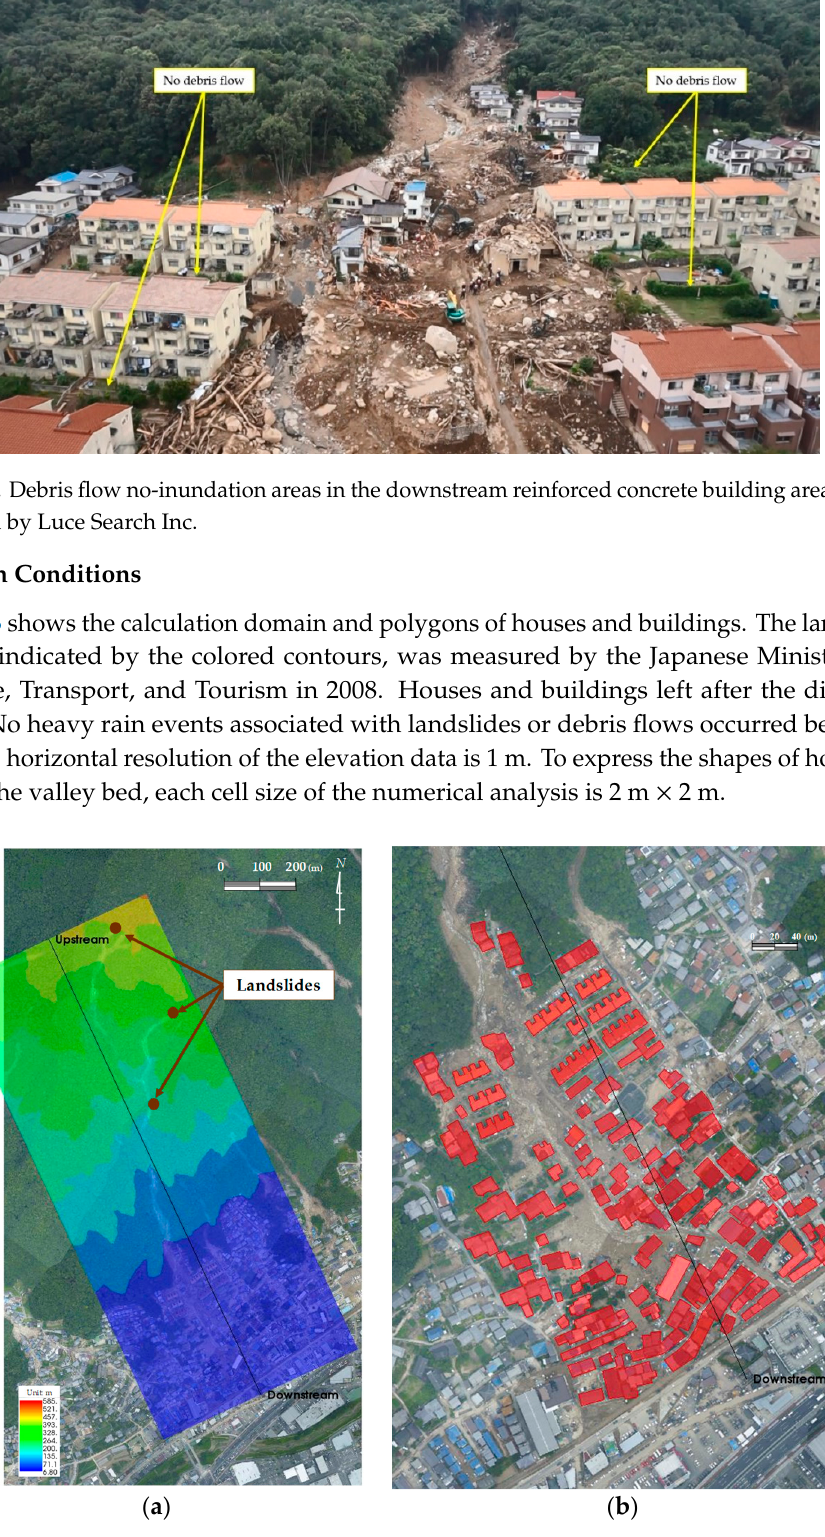
Figure 11. Damaged houses in the residential area, Asaminami, Hiroshima. ( a ) and ( e ), which were taken by Luce Search Inc., show damaged houses. ( b ) shows reinforced concrete buildings with small damages. ( c ), which was taken by Japanese Ministry of Land, Infrastructure, Transport and Tourism, is an aerial image after the disaster. ( d ), which is from Google Earth, is an aerial image before the disaster.